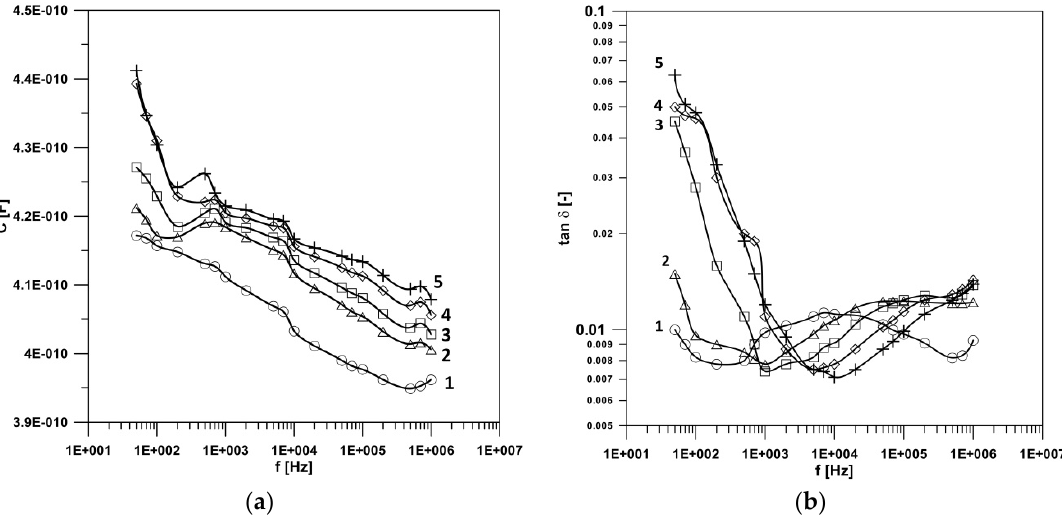
Figure 3. The influence of temperature on the characteristics of capacitance C ( a ) and loss factor tan δ ( b ) of the non-aged aramid insulation sample impregnated with mineral insulating oil: 1–20 °C, 2–40 °C, 3–60 °C, 4–80 °C, 5–100 °C.